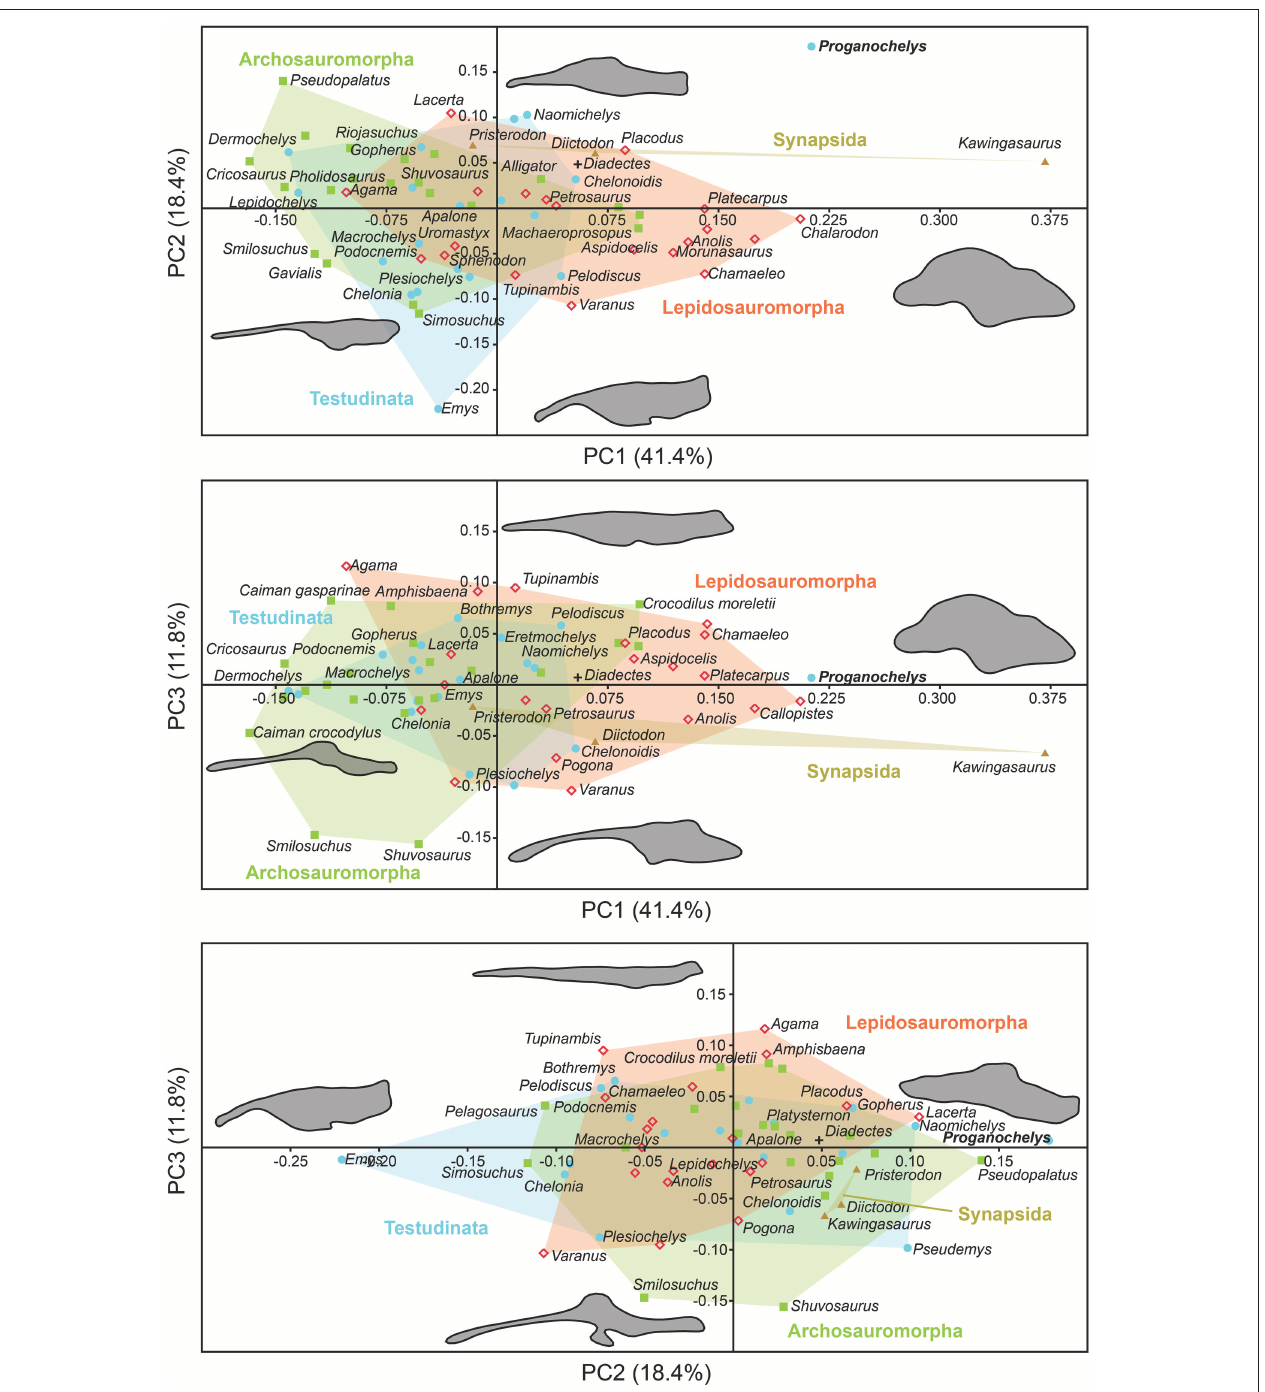
FIGURE 5 | Two dimensional morphospace plots of brain endocast outlines based on the first three PC axes using a priori defined phylogenetic groups. Diadectes is shown as a black cross, Proganochelys quenstedti (SMNS 16980) in bold. The symbols are used to identify the clade to which a point was assigned. Different vertebrate groups are indicated by convex